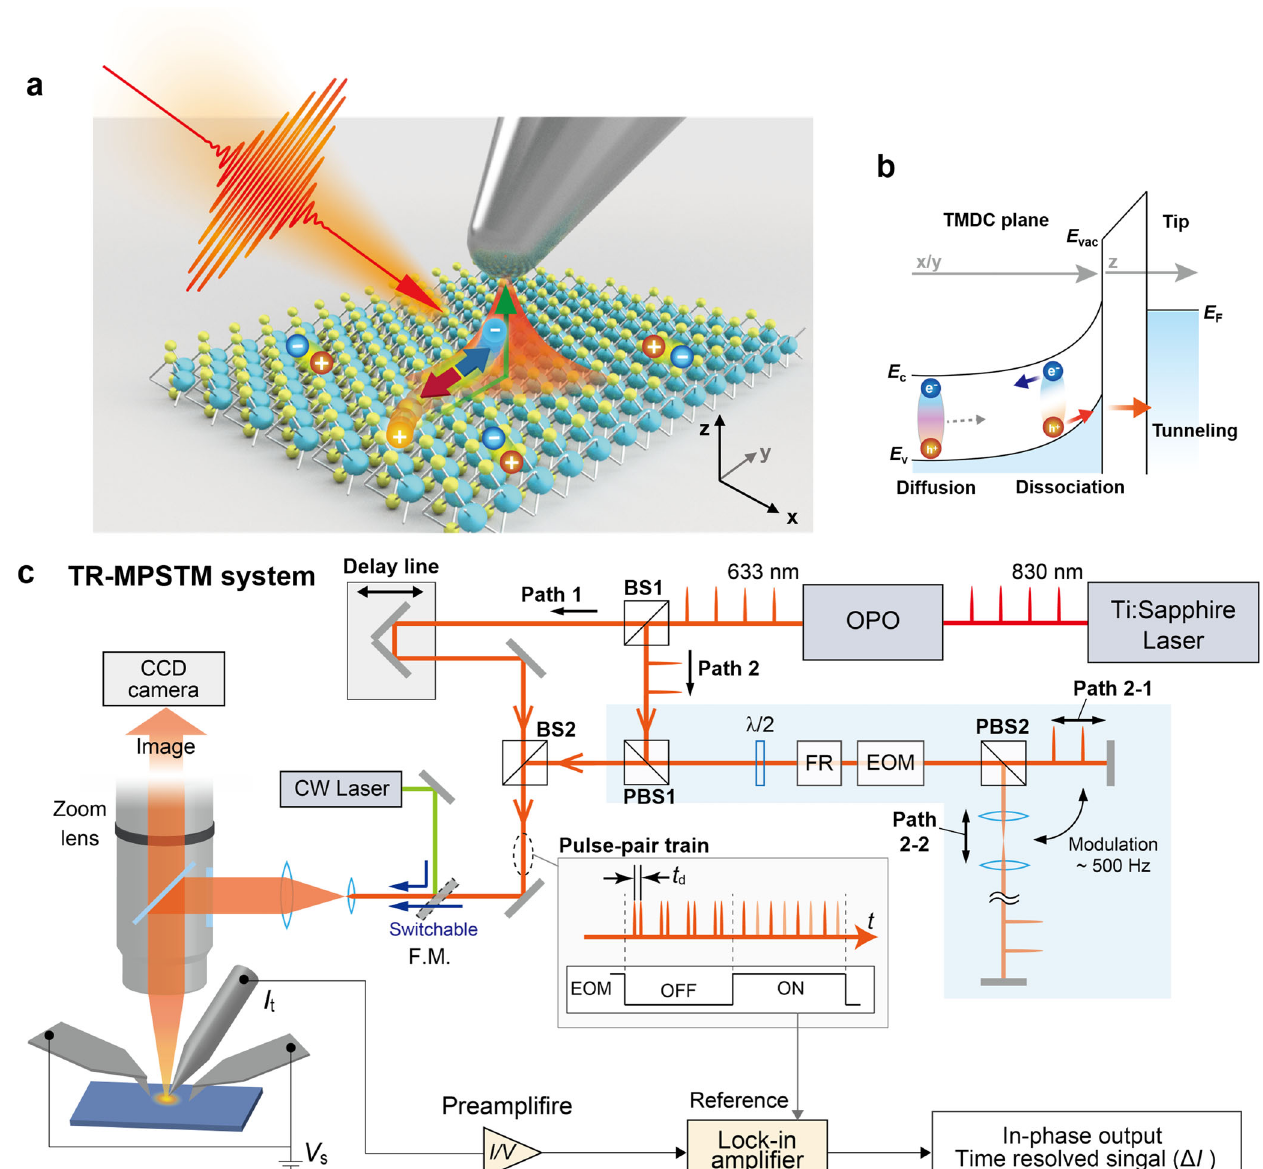
Fig. 1 Schematic illustrations of exciton dynamics in two-dimensional materials. a Time-resolved STM (TR-STM) setup for measuring carrier dynamics in TMDCs. b Band structure showing the mechanism to detect excitons by STM. The direction of the band bending depends on the bias voltage applied between the STM tip and the sample. c Schematic structure of the time-resolved-multiprobe STM system we have developed. BS beam splitter, PBS polarized beam splitter, OPO optical parametric oscillator, FR Faraday rotator, EOM electro-optical modulation element (see Supplementary Fig. 1 for